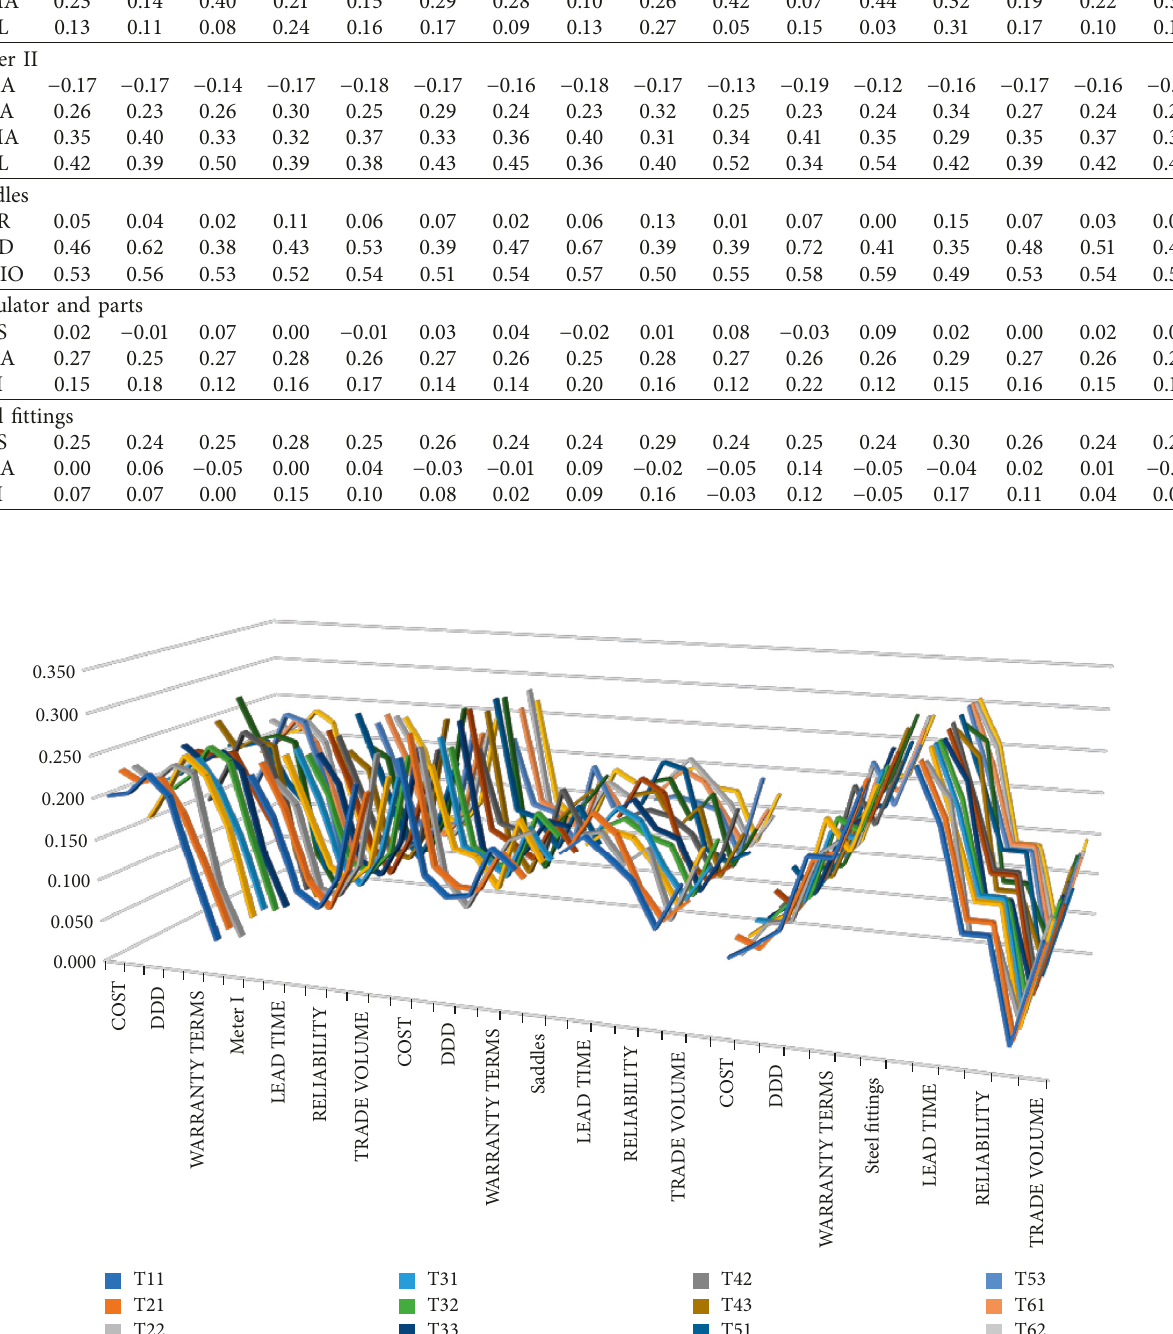
k values in terms of developed